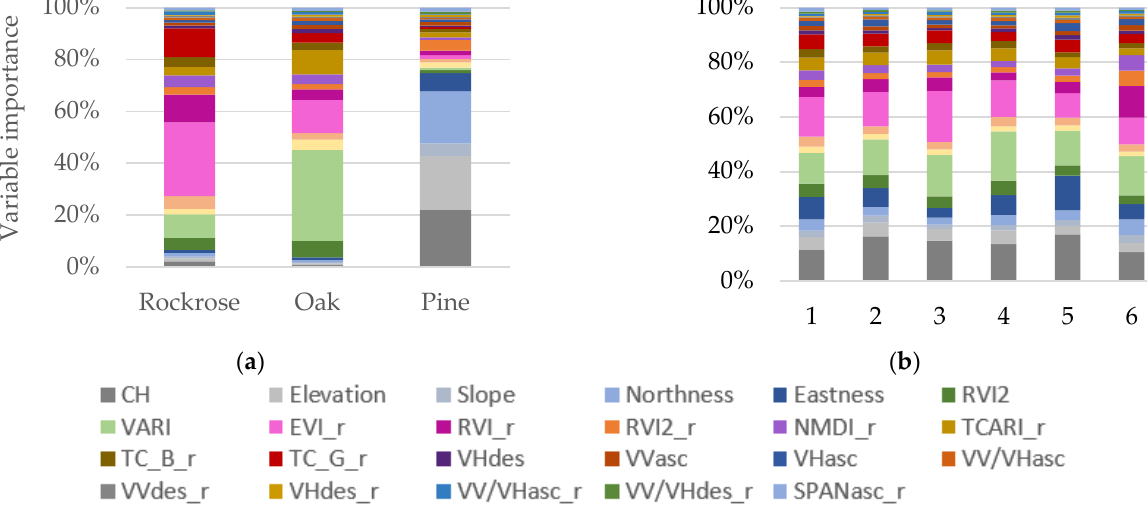
Figure 6. Predictor variables ’ importance for LFMC estimation by species ( a ) and by location ID ( b ).